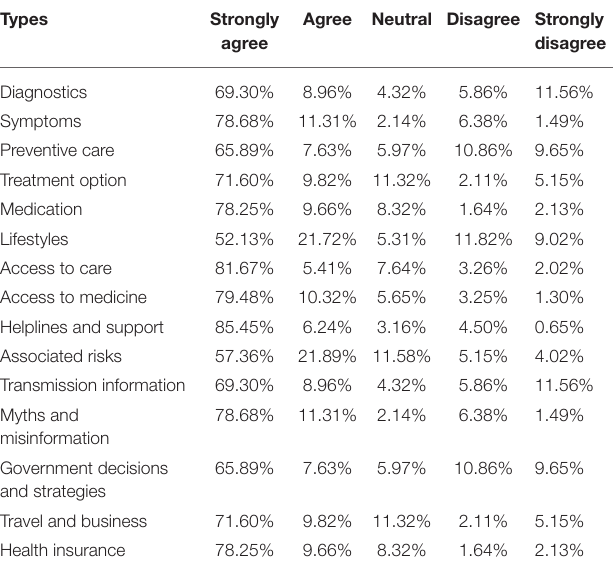
TABLE 7 | Types of information for COVID-19 awareness and management.